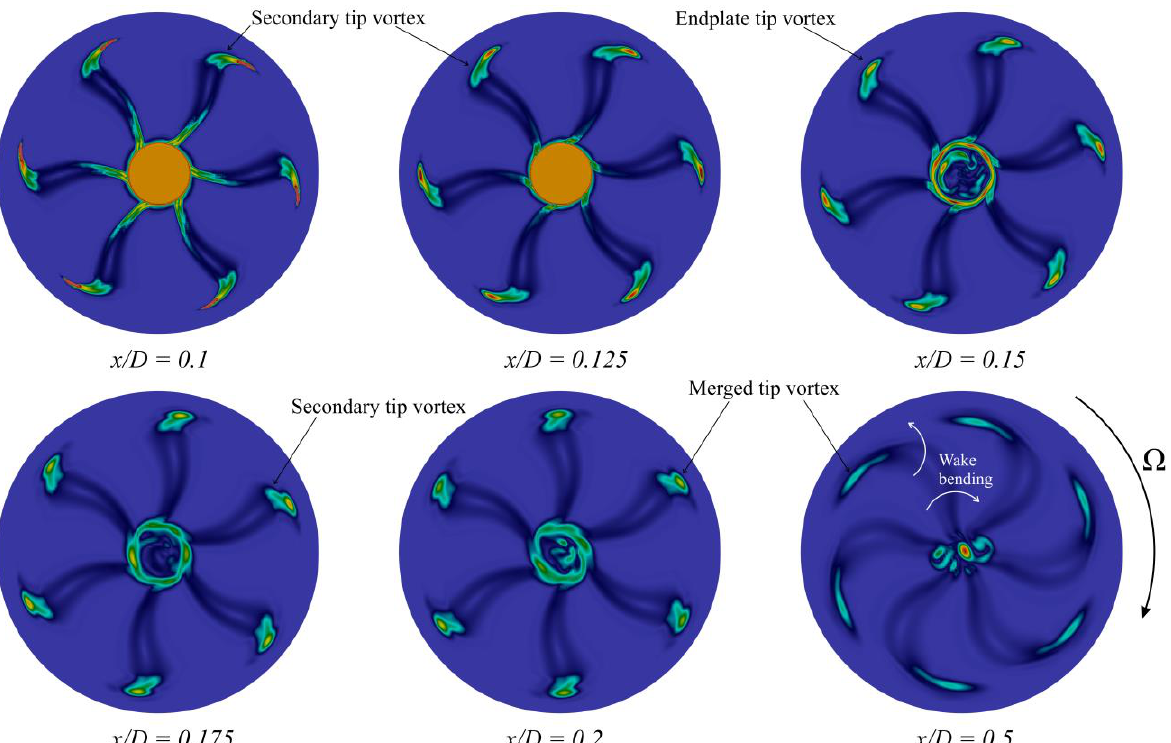
Figure 18. Transverse distributions of vorticity (magnitude) at different axial locations downstream the propeller. New generation CLT propeller at the design advance coefficient ( J = 0.9).